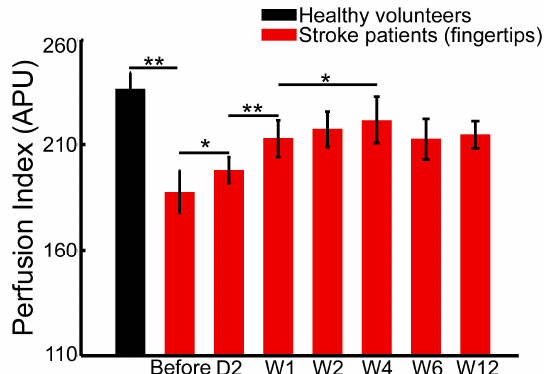
Figure 3. Averaged perfusion changes in the fingertips of healthy volunteers and stroke patients before, during, and after six weeks of rehabilitation therapy (* p < 0.05; ** p < 0.01).